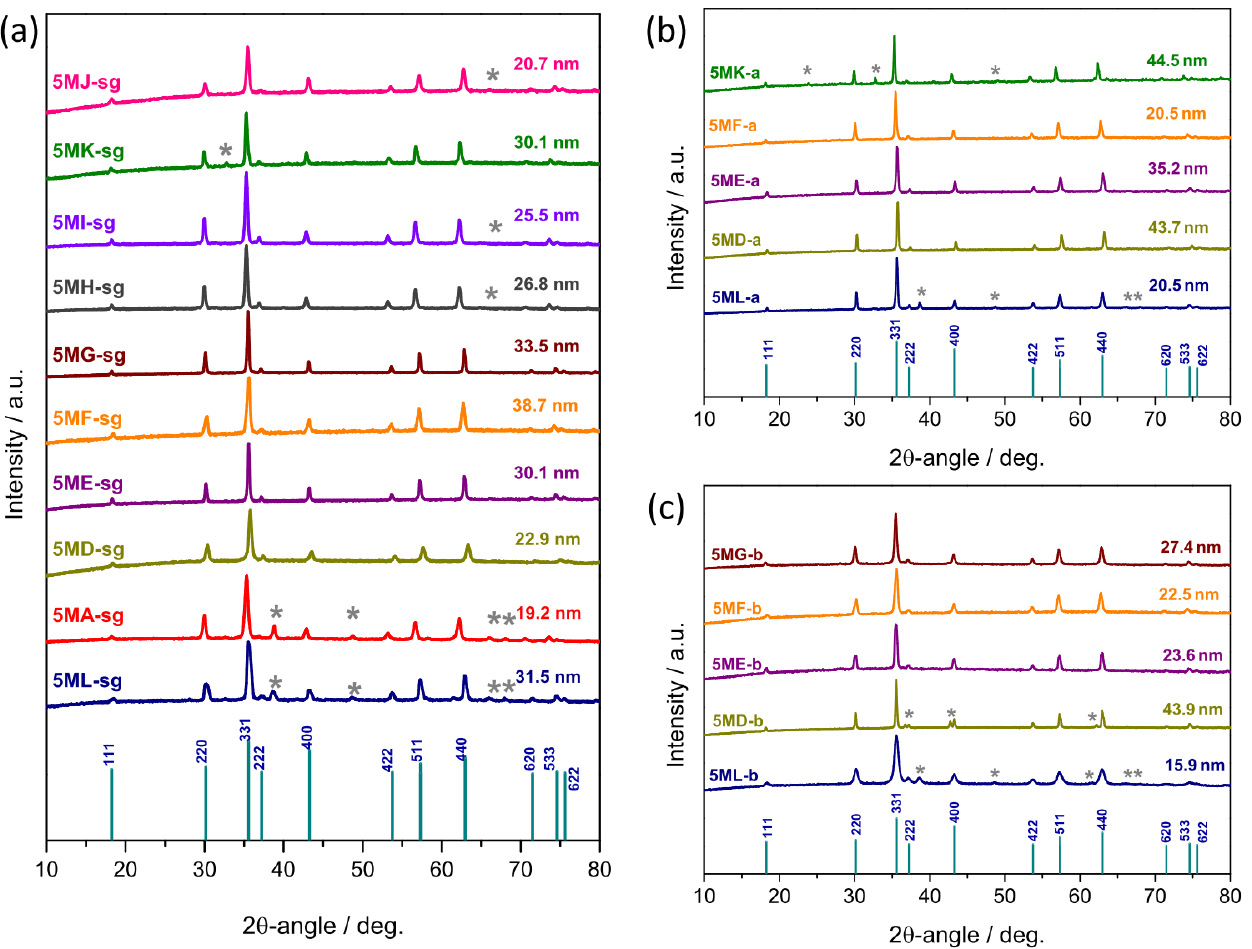
Figure 3. XRD patterns of the samples produced via ( a ) sol-gel method and ( b , c ) electrospinning by the use of ( b ) PVP and ( c ) PAN as a polymer. Stars mark reflections not assignable to the spinel phase.